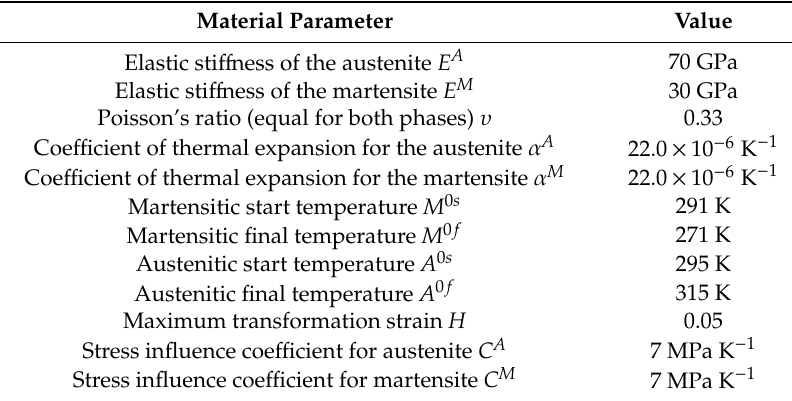
Table 2. Material parameters for NiTi SMA data from [29].